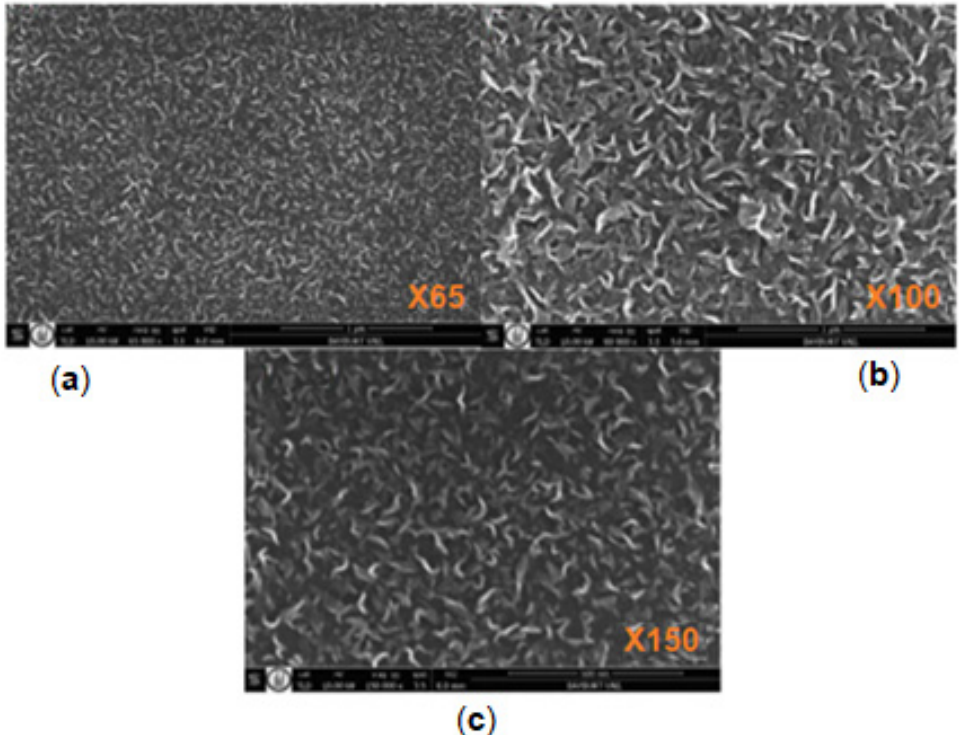
Figure 6. SEM images of PECVD grown graphene nanowalls at different magnifications at ( a ) × 65, ( b ) × 100, and ( c ) × 150.